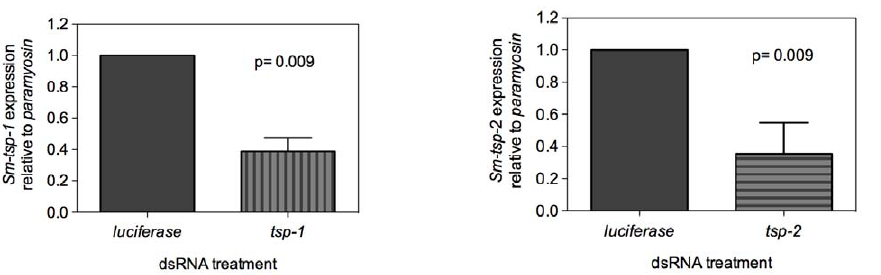
Figure 3. Suppression of Sm-tsp mRNAs in adult parasites by RNAi. Sm-tsp-1 (A) and Sm-tsp-2 (B) transcript levels relative to Sm - paramyosin (mean 6 S.E.) in adult parasites soaked for 7 days with 1 m g/ml of Sm-tsp or luciferase control